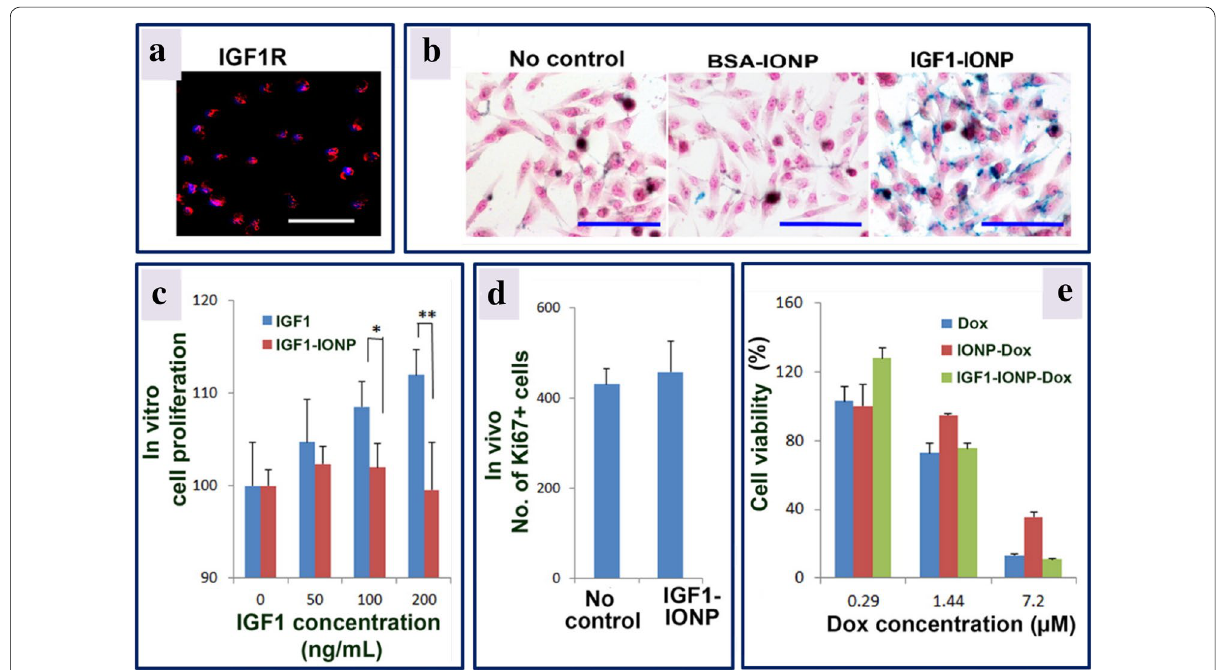
Fig. 3 In vitro and in vivo effects of IGF1-IONPs (insulin-like growth factor 1-iron oxide nanoparticles) and IGF1-IONPs-doxorubicin on cell proliferation and viability. a The effect of IGF1R in MIAPaCa-2 cells was assessed by immunofluorescence labeling employing an anti-IGF1R antibody (shown in red color). b Prussian blue staining of cells incubated for 4 h with different treatments at 20 μg/mL of iron equivalent dose. The cells are also counterstained with nuclear fast red. c The in vitro influence of IGF1 and IGF1-IONPs on cell proliferation. The % of viable cells after 96 h incubation with IGF1 or IGF1-IONPs, and for 4 h at equivalent IGF1 concentrations was estimated by cell proliferation assay, wherein *P < 0.05; **P < 0.001. d The in vivo effect on tumor cell proliferation of IGF1-IONPs in human pancreatic PDX-tumor xenografts. By using immunofluorescence labeling of an anti-Ki67 antibody, the Ki67-positive cells in tumor sections after two tail vein injections of 20 mg/kg iron dose of IGF1-IONPs are measured. e In vitro cytotoxicity of unconjugated and conjugated doxorubicin in MIA PaCa-2 cells. The scale bars are 100 μm (adapted with permission from